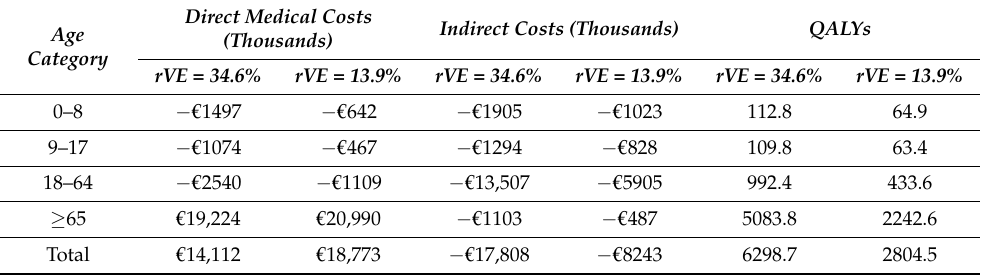
Table 12. Incremental costs and QALYs results aQIV vs. QIVe.